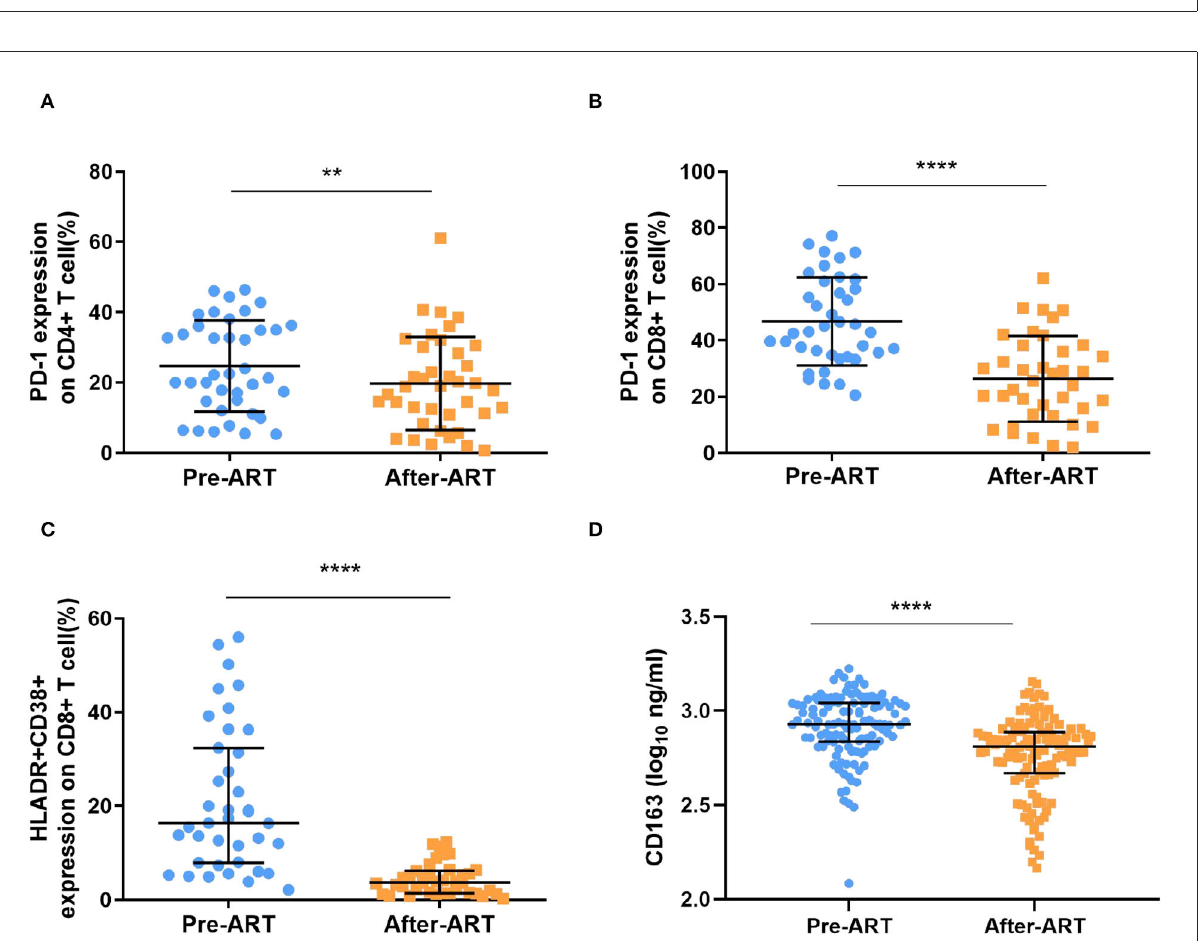
FIGURE4 Markers of immune activation after ART. (A,B) The percentage of PD-1 expressing on CD4 + T cells and CD8 + T cells were significantly decreased after ART ( n = 39, paired Kruskal–Wallis test; paired t test). (C) the expression of HLADR + and CD38 + within CD8 + T cells was significantly reduced ( n = 39, paired Kruskal–Wallis test). (D) The levels of plasma CD163 was detected by ELISA, which decreased significantly ( n = 120, paired Kruskal–Wallis test). **** p < 0.0001, ** p < 0.01.